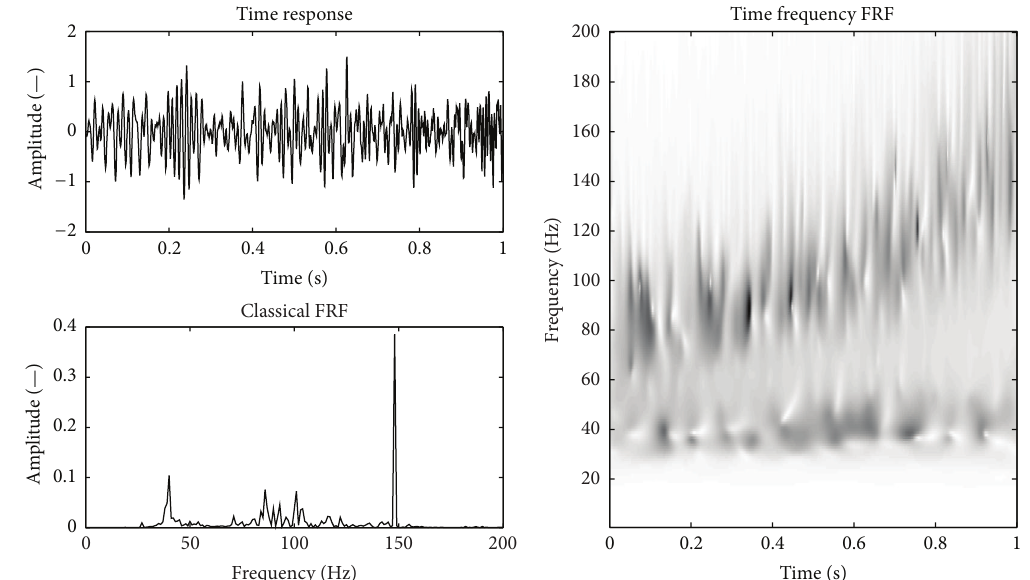
Figure 9: Simulated results obtained for the white noise excitation in the time, frequency, and combined time-frequency domains.